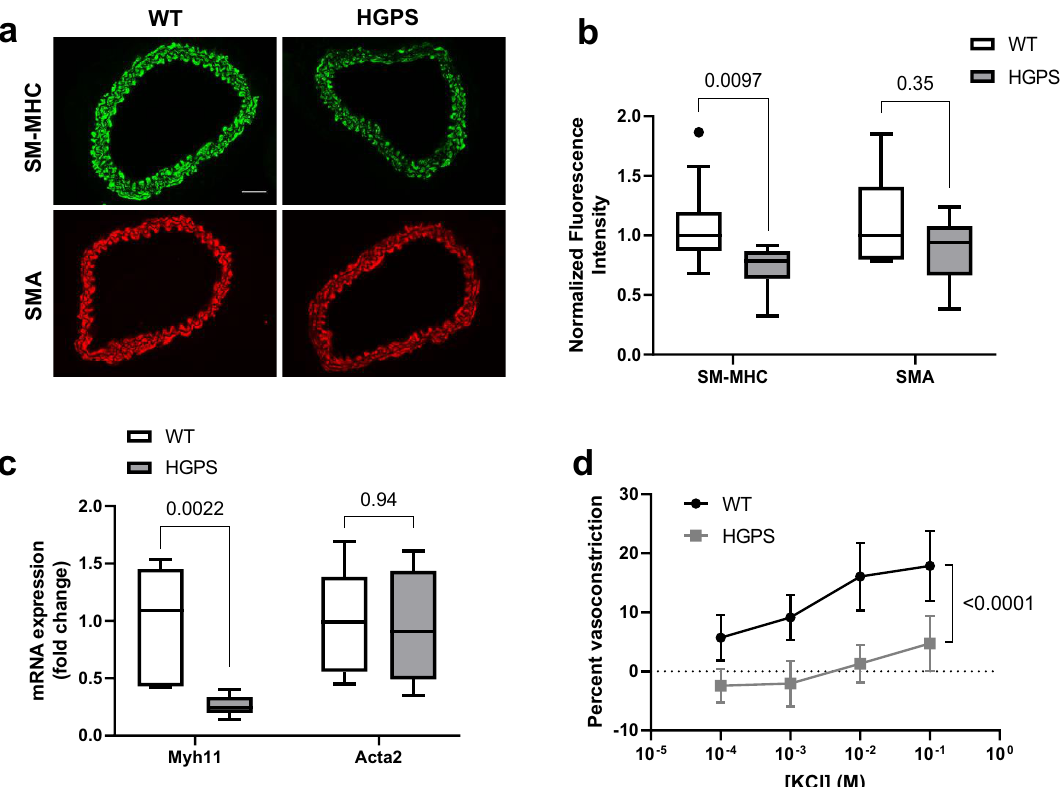
Figure 2. Reduced smooth muscle myosin heavy chain and decreased contractility in HGPS carotid arteries. ( a ) Representative images of 2-month WT (n = 10) and HGPS (n = 7) carotid artery cross sections immunostained for SM-MHC and SMA; scale bar = 50 µm. ( b ) Quantification of carotid artery immunostaining with results plotted relative to the WT controls. ( c ) Carotid arteries from 2-month WT and HGPS mice (n =